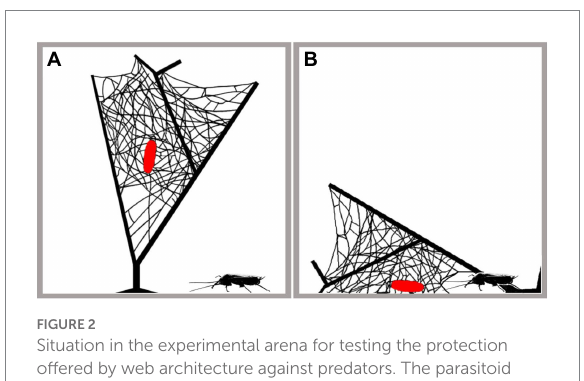
FIGURE 2 Situation in the experimental arena for testing the protection offered by web architecture against predators. The parasitoid cocoon with pupa (in red) was protected by a 3D silk structure. Cocoons were located either in an aerial web (A) or in a web that was placed on the ground (B) .